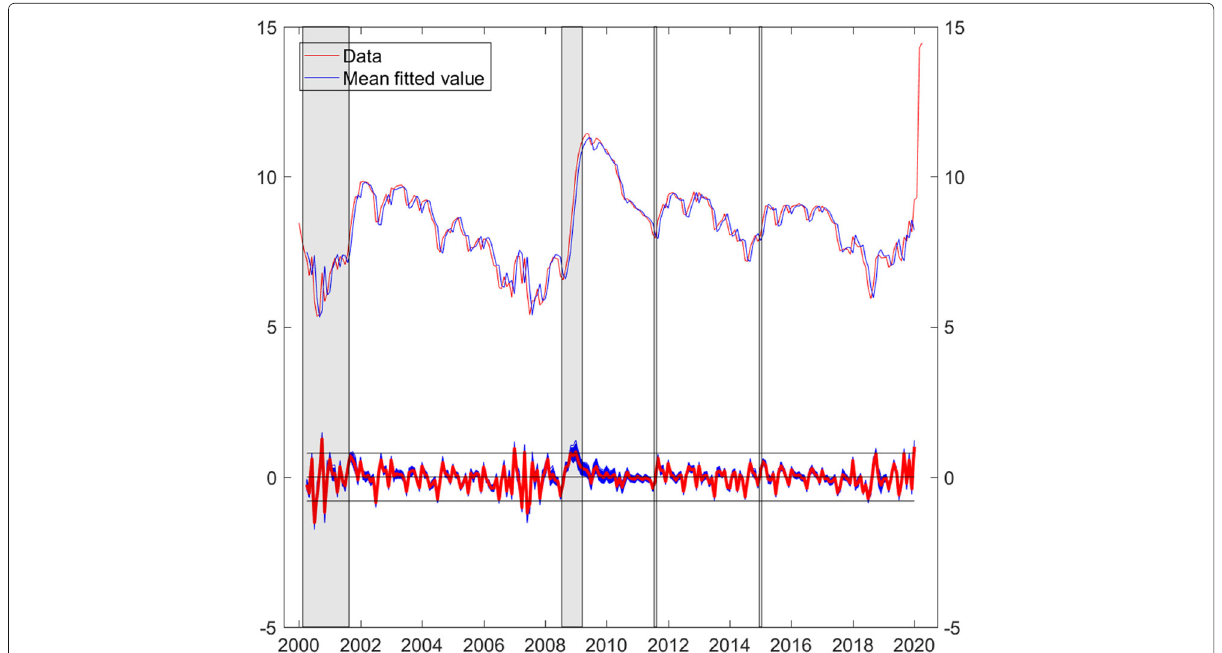
Fig. 4 Log short-time workers. Data and mean fitted values, error (shock) series (mean in red). Sample period: April 2000–January 2020. Gray bars highlight the dotcom and financial crises, the introduction, and discontinuation of the euro-Swiss franc floor